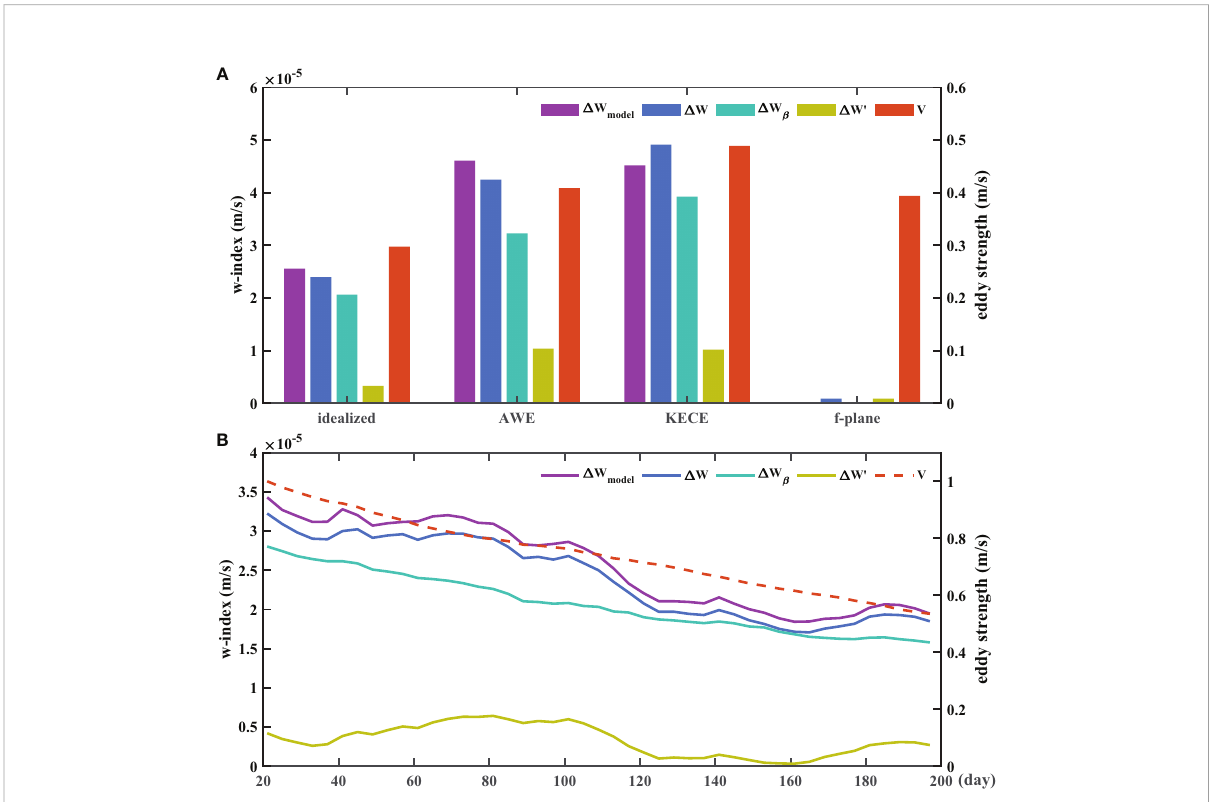
FIGURE 8 (A) Bar diagram of the time mean w -dipole indices obtained from model outputs ( D w model , purple bars), w -equation with all terms ( D w , blue bars), w -equation with the b -term only ( D w b , green bars) and w -equation without the b -term ( D w ", yellow bars) for the idealized eddy on the b -plane ( b -plane), the Agulhas warm eddy (AWE), the Kuroshio extension cold eddy (KECE) and the idealized eddy on the f -plane ( f -plane), respectively. Red bars represent the corresponding eddy strength ( V ). (B) Temporal variation in the w -dipole indices and the corresponding eddy strength ( V ) of the idealized eddy on the b